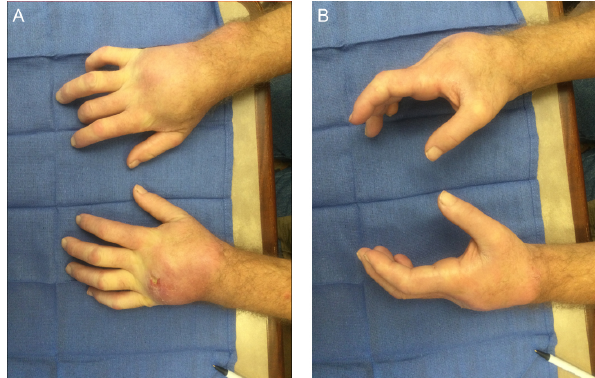
Figure 4. Clinical appearance of the patient’s bilateral wrists at (a) terminal pronation and (b) neutral. The bilateral wrists demon- strate profound edema and erythema over the dorsum of the wrists. A draining defect is appreciable over the ulnar dorsum of the left